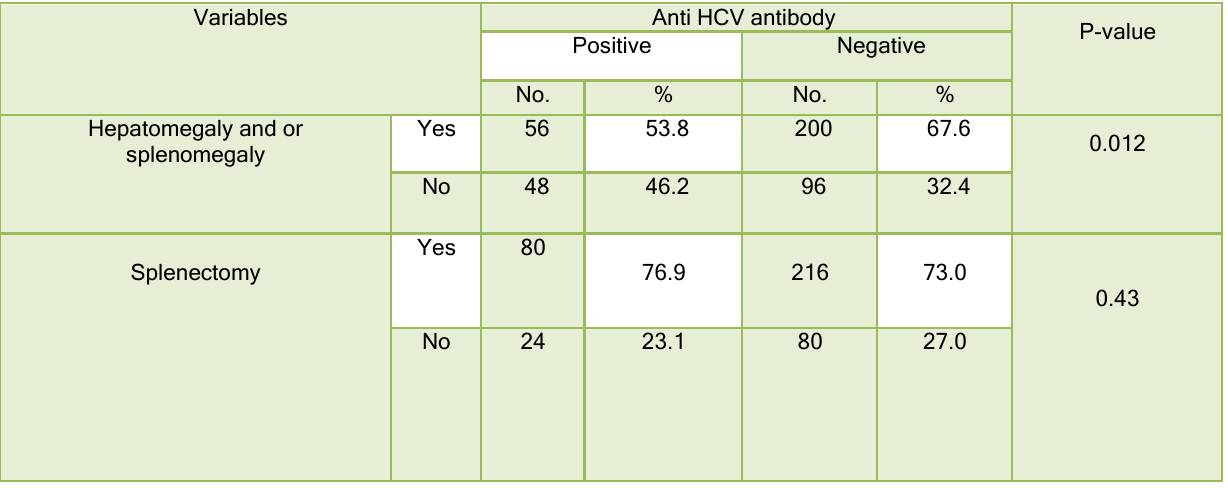
Table 7: The relationship of clinical finding with occurrence of